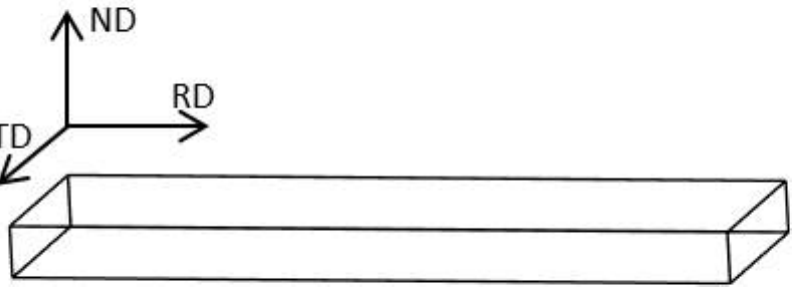
Figure 1. Schematic diagram of sample observation surface.